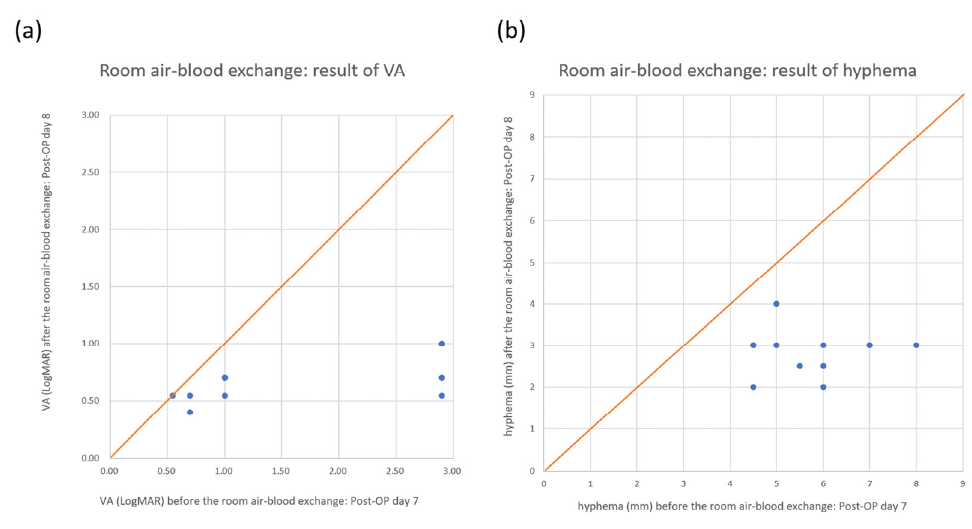
Figure 3. Visual acuity (VA) and hyphema changes after the air–blood exchange procedure with room air. From the scatter plot, we can see that nearly all the spots are below the 45° orange line. This means that VA ( a ) and hyphema ( b ) improved in nearly all the patients.